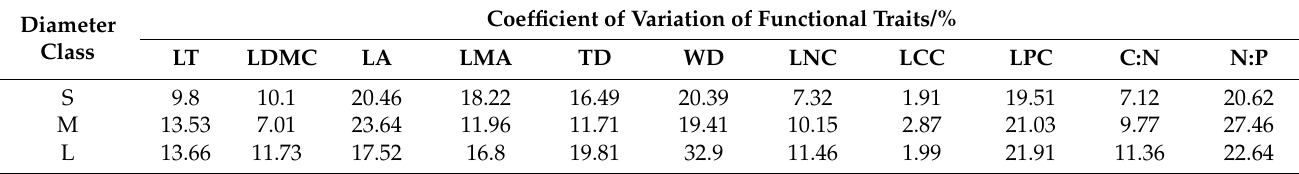
Table 3. Variability of the functional traits in different diameter classes.